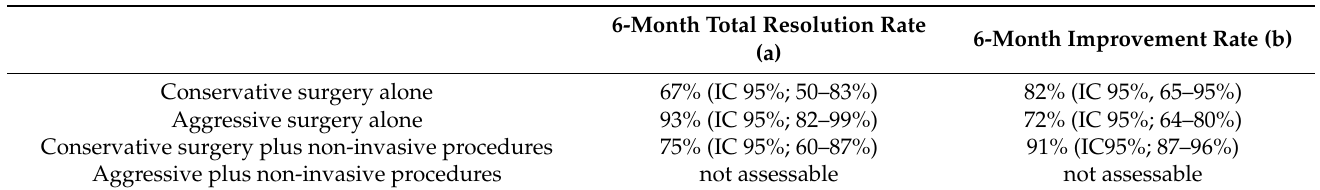
Table 4. Stratification for each category of invasive procedures with respect to (a) and to